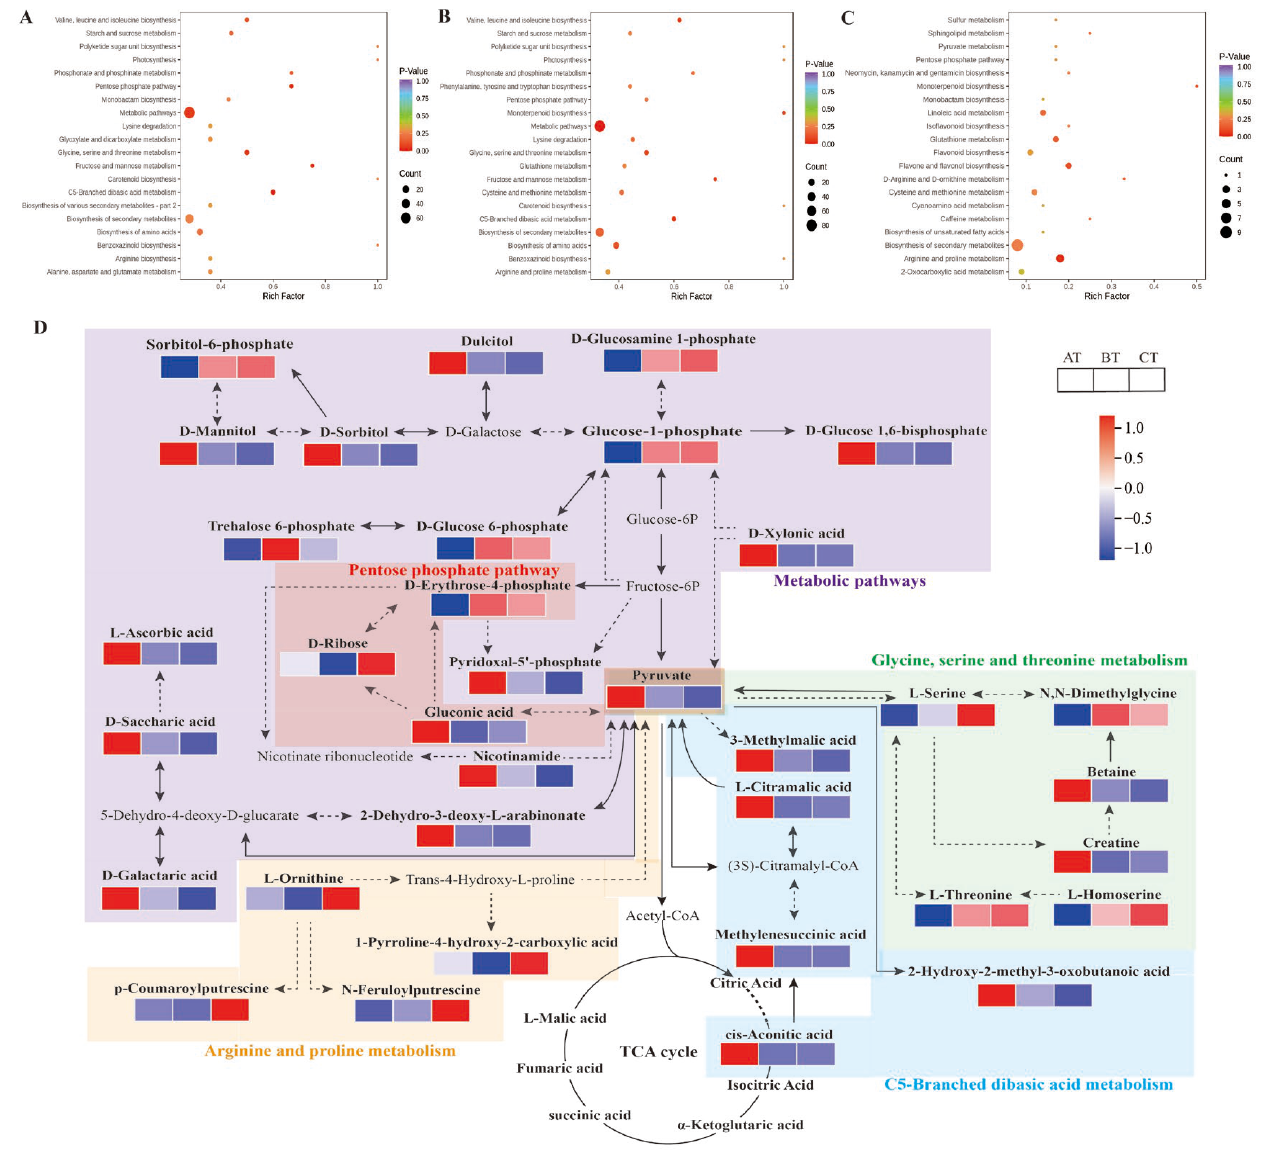
Figure 5. ( A – C ) Differential metabolite KEGG enrichment maps and ( D ) Metabolic pathway maps for different age sections of P. cyrtonema, grey font represents non-detected metabolites, solid arrows represent individual reactions, and the dashed arrows indicate conversions with multiple steps catalysed. ( A ) AT vs. BT, ( B ) AT vs. CT, ( C ) BT vs. CT.